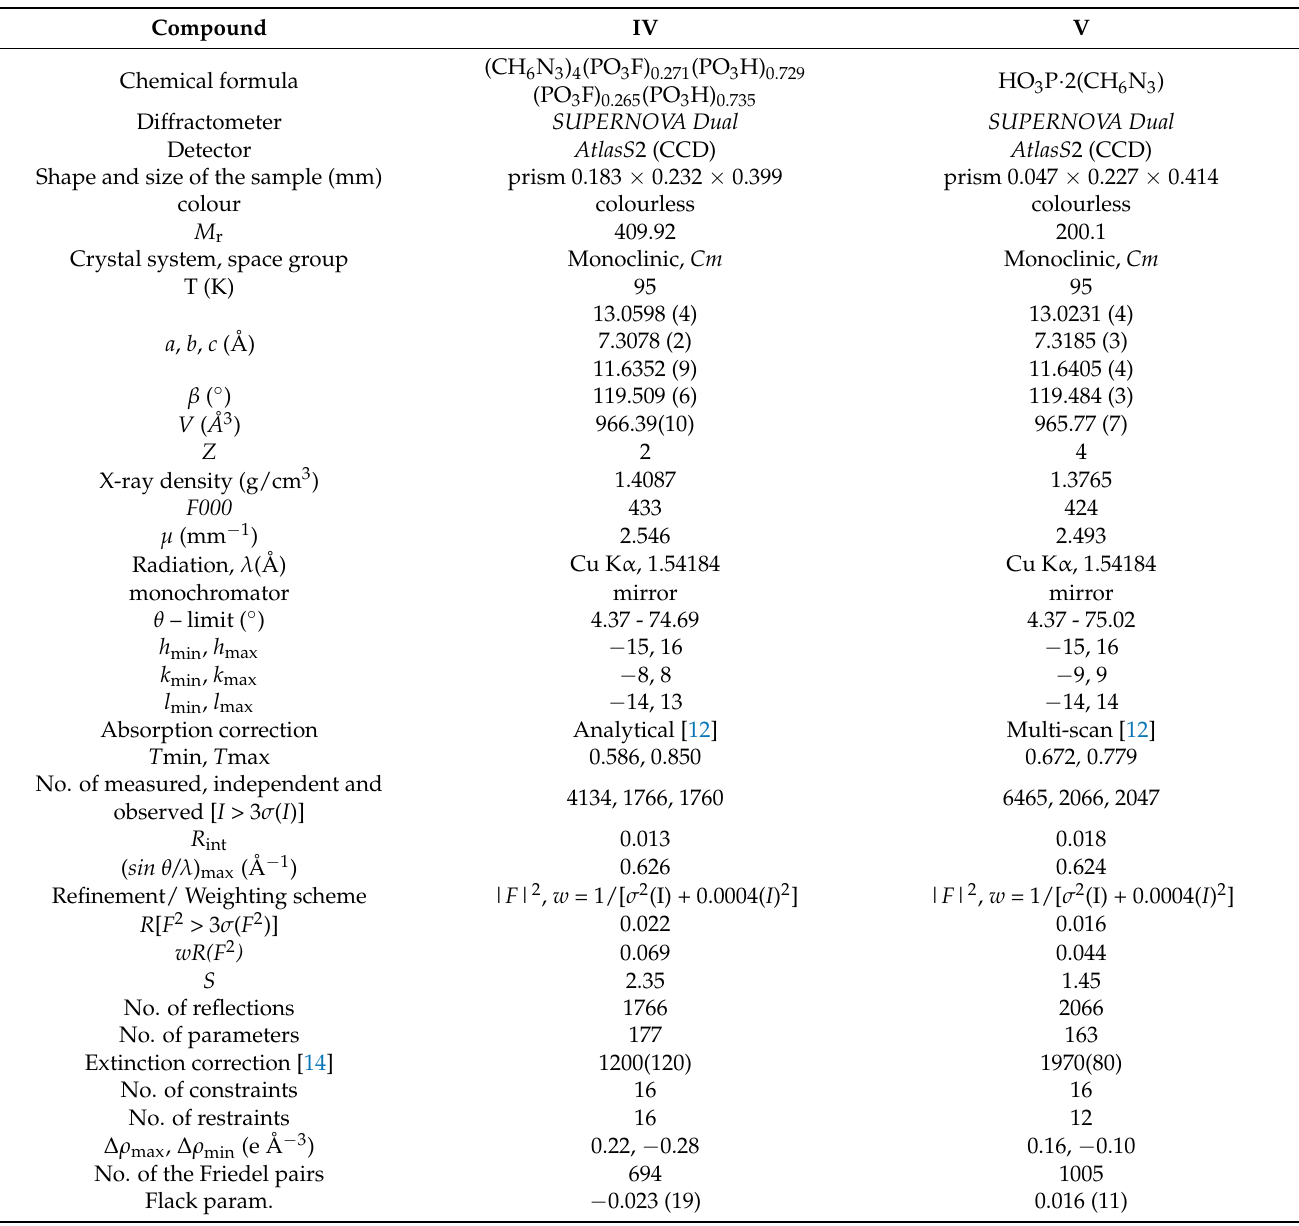
Table 2. Crystal data and details of data collection and refinement for compounds ( IV ) and ( V